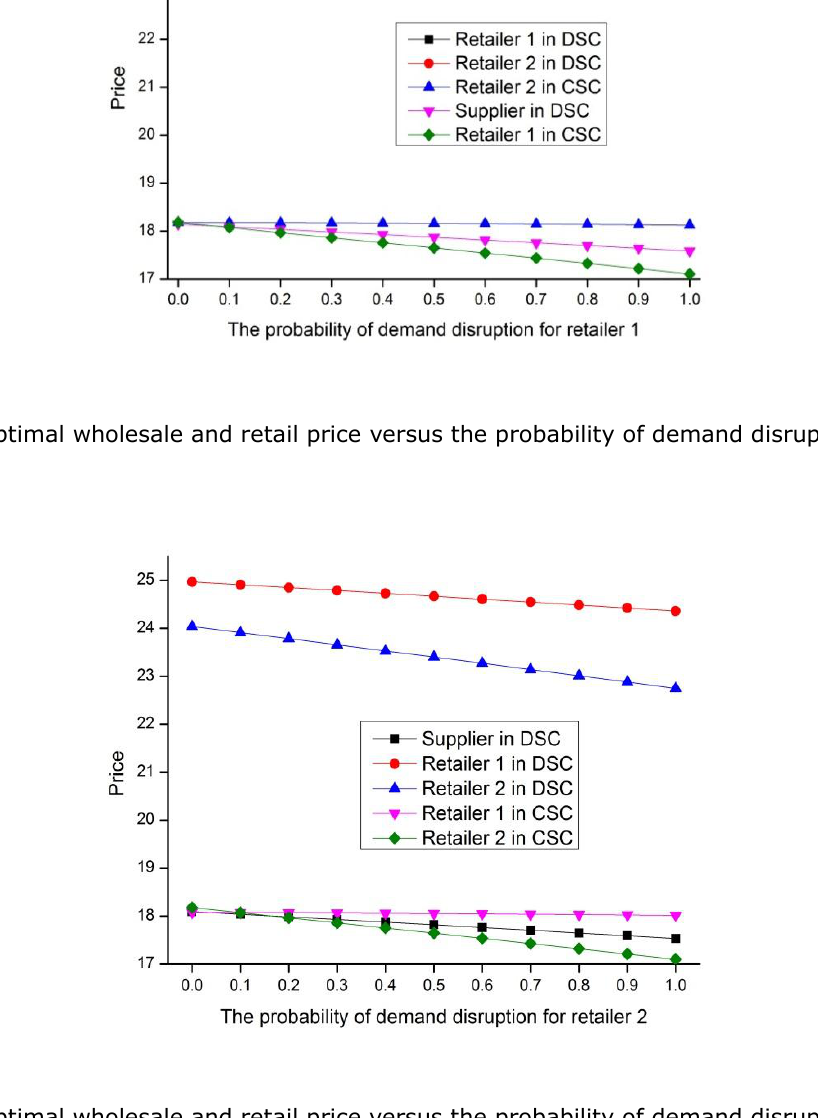
Figure 2. The optimal wholesale and retail price versus the probability of demand disruption for retailer